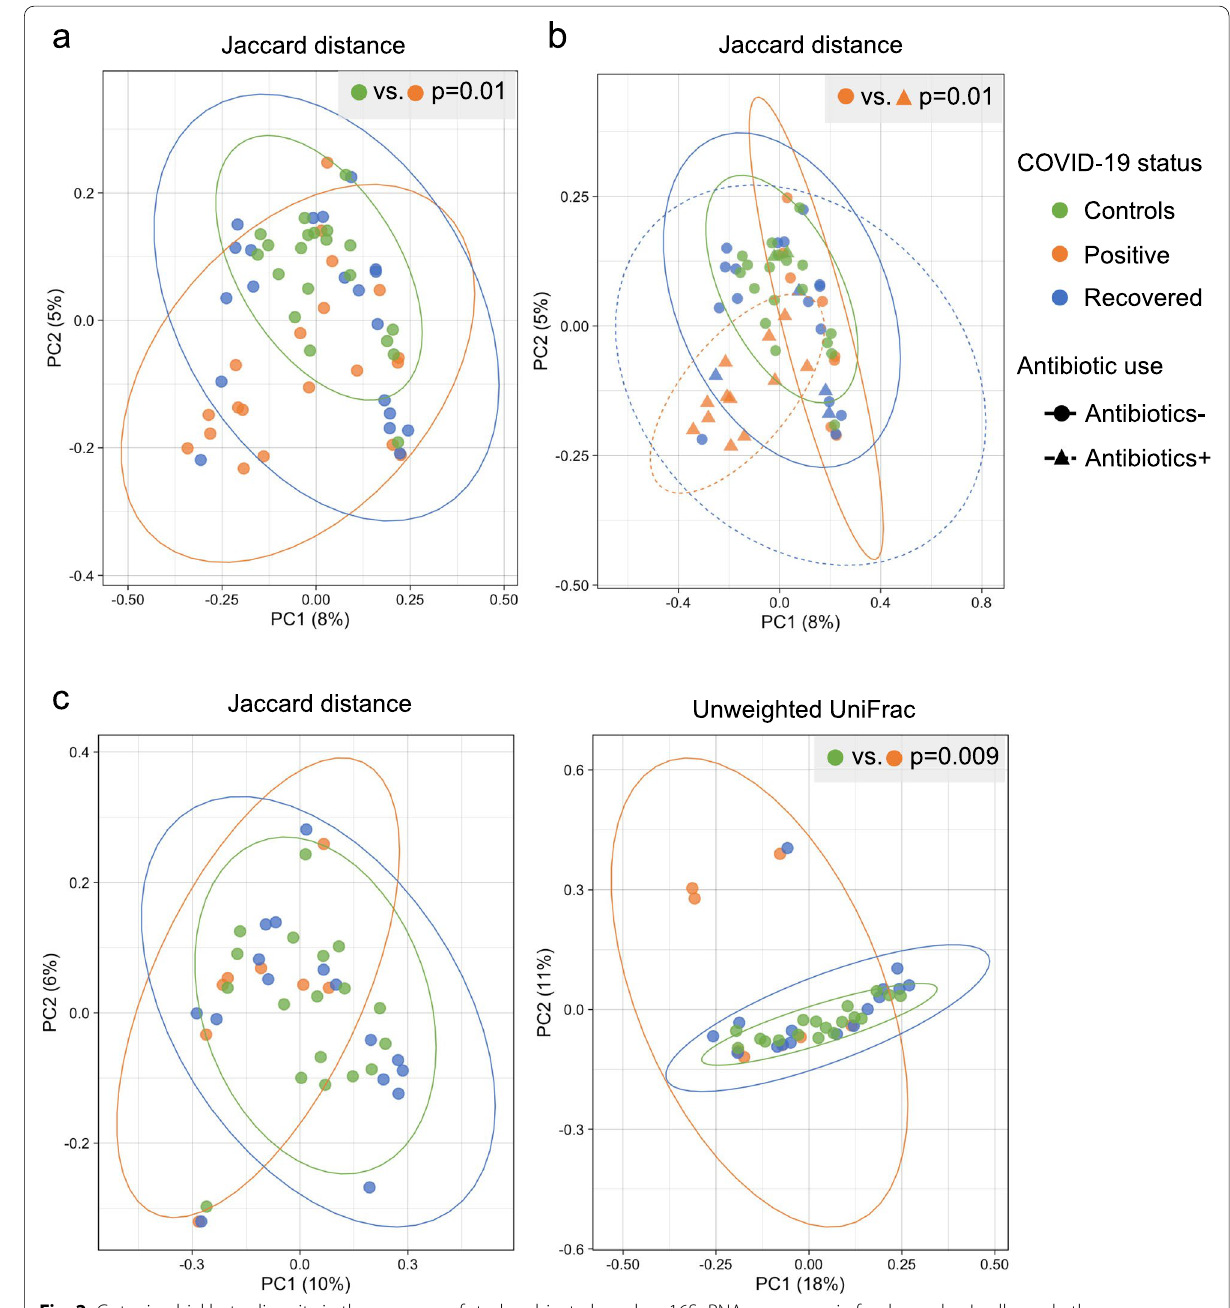
Fig. 2 Gut microbial beta-diversity in three groups of study subjects, based on 16S rRNA sequences in fecal samples. In all panels, the ellipses represent 95% confidence intervals, and p -values were obtained by PERMANOVA. a, b Principal coordinates analysis (PCoA) was used for visualization of Jaccard dissimilarity of gut microbial communities between the Controls (n COVID-19-recovered patients (n 20). b Groups of subjects with or without antibiotic use were compared. c PCoA based on Jaccard distance and = unweighted UniFrac distance are shown for subjects in the absence of recent antibiotic exposure. Table 1 indicates the number of subjects in each